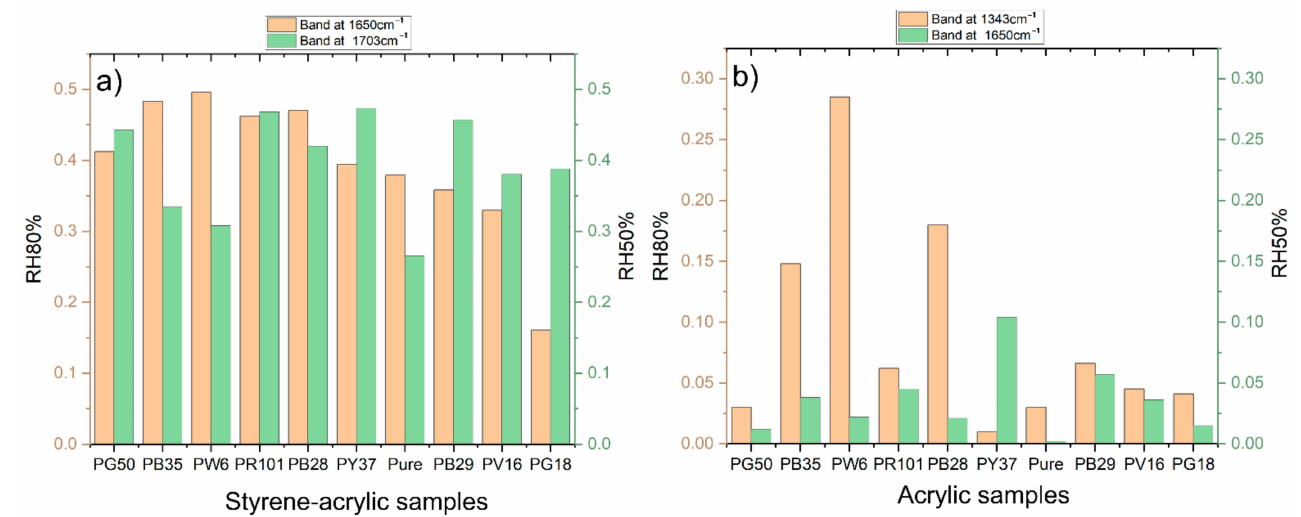
Figure 8. Semi-quantification evaluation of selected spectral signals on ( a ) styrene-acrylic and ( b ) acrylic paints. Comparison between integration areas of 50% RH aged (green) and 80% RH aged (orange)